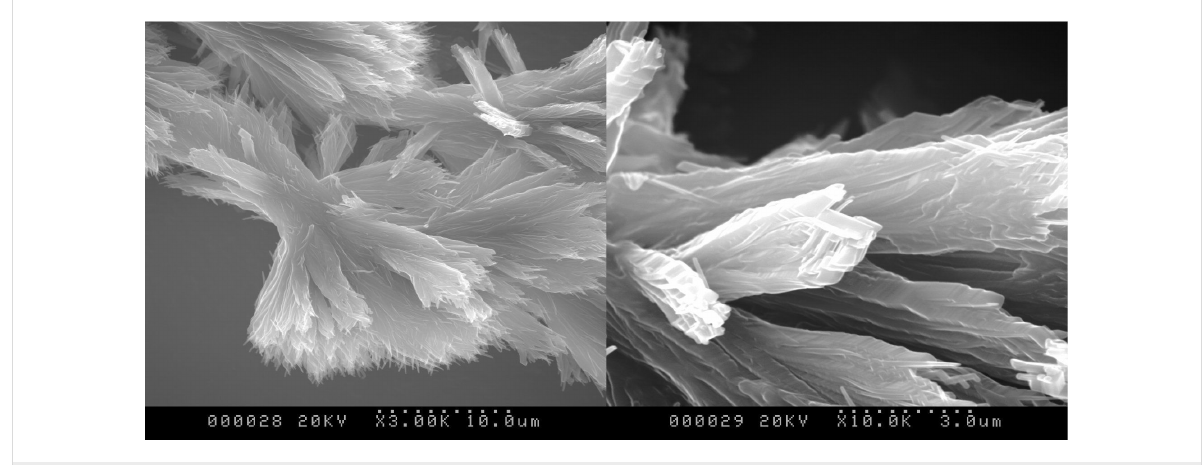
Figure 4: SEM micrographs of β -Ala-His-EO 2 -C 14 hydrogels after drying.